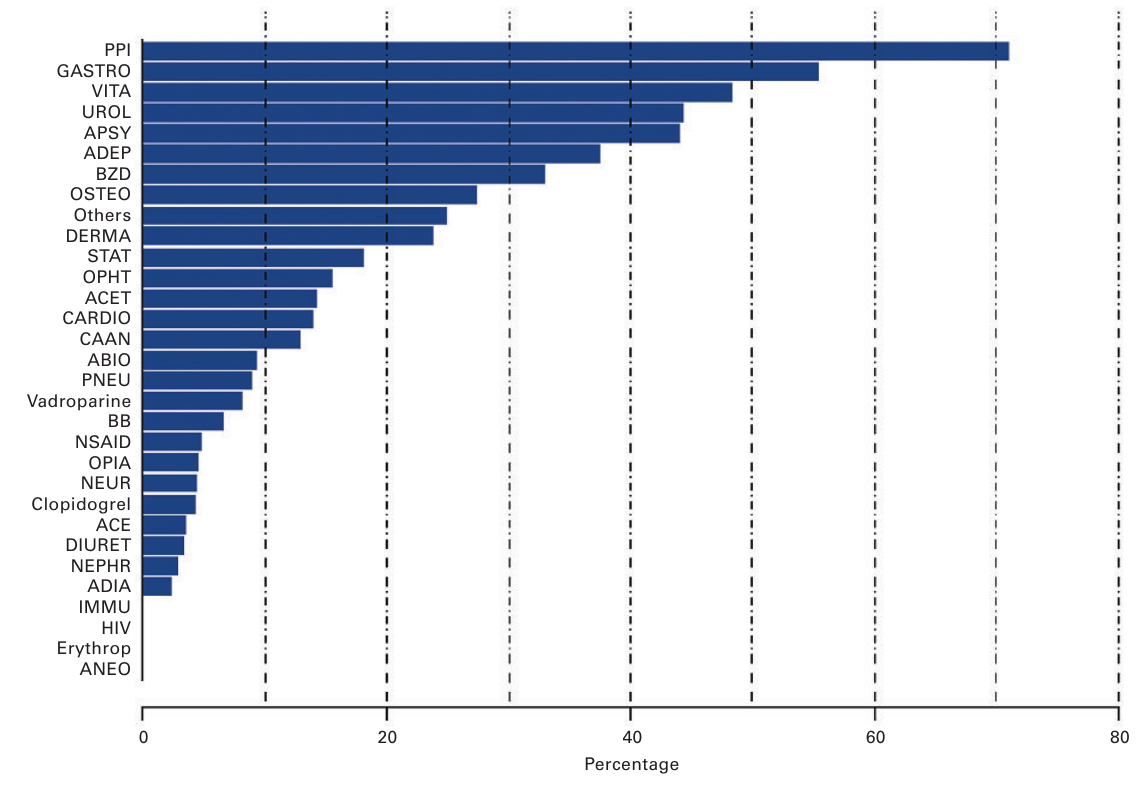
Figure 2 Percentage of the unnecessary drugs taken from the total monthly expenditures, per class of medications.The abbreviations stand for: ABIO, antibi- otics; ACE, angiotensin converting enzyme inhibitor; STAT, statins; ADEP, antidepressants; ADIA, antidiabetics; NSAID, non steroidal anti inflammatory drugs; Others, other drugs; ACET, acetaminophen; IMMU, immunsuppressive agents; BB, beta-blockers; BZD, benzodiazepines; CAAN, calcium antago- nists; CARD, other cardiologic drugs; DERMA, dermatologicals; DIURET, diuretics; GASTRO, other gastrointestinal agents; HIV, HIV (anti) agents; NEPHR, renal failure (agents); APSY, anti psychotics; NEUR, neurologic disease agents; OPHT, ophthalmic preparations; ANEO, antineoplastic agents; OPIA, opiates; OSTEO, anti osteoporosis agents; PNEU, pneumologics; PPI: proton pump inhibitors; UROL, urologics; VITA,